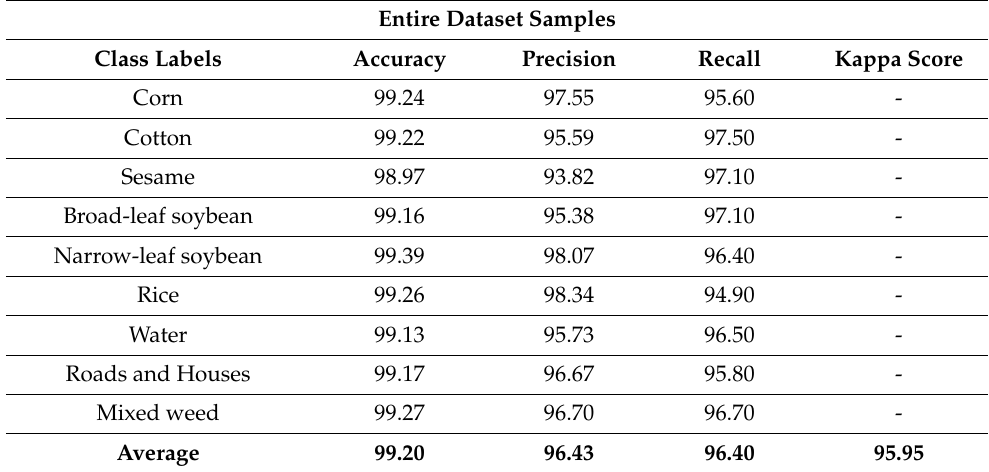
Table 1. Result analysis of the SSODTL-CC technique with distinct classes under all of dataset-1.